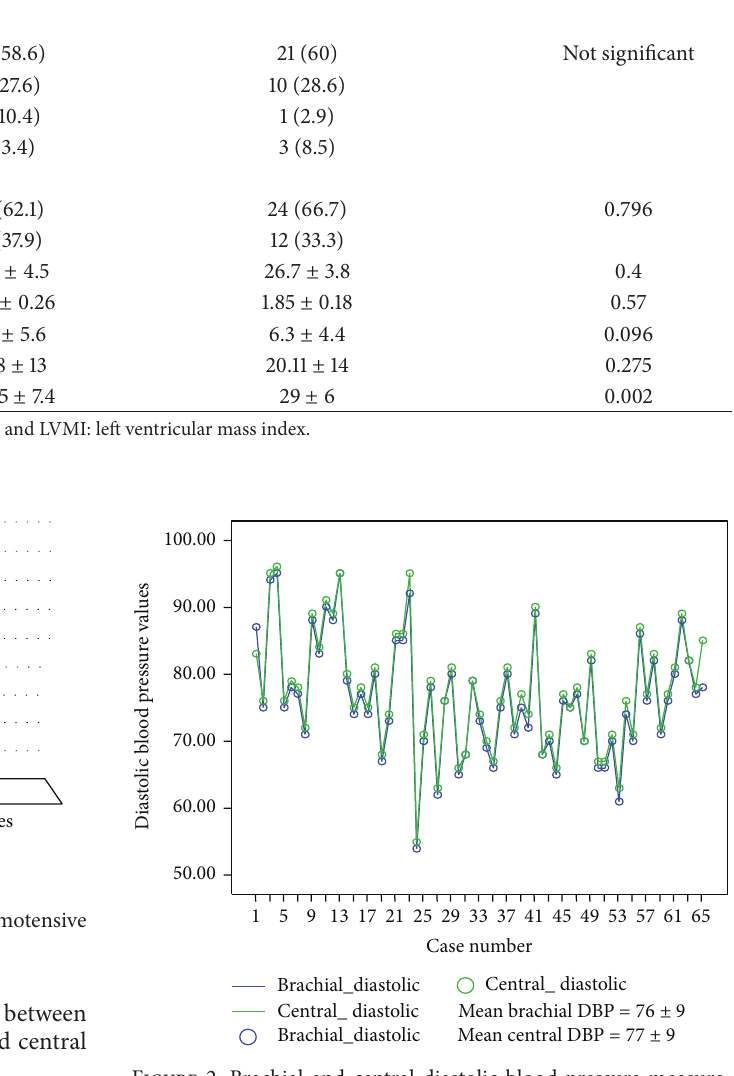
Figure 2: Brachial and central diastolic blood pressure measure-